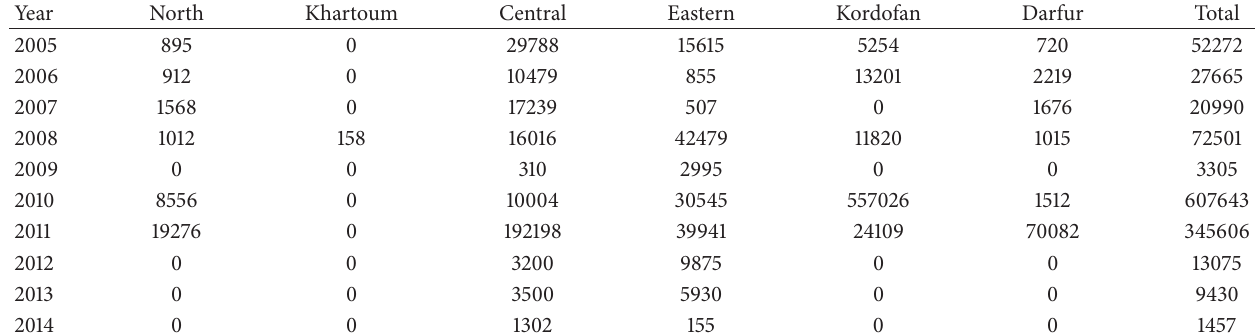
Table 20: Charcoal by state (tons) [8].